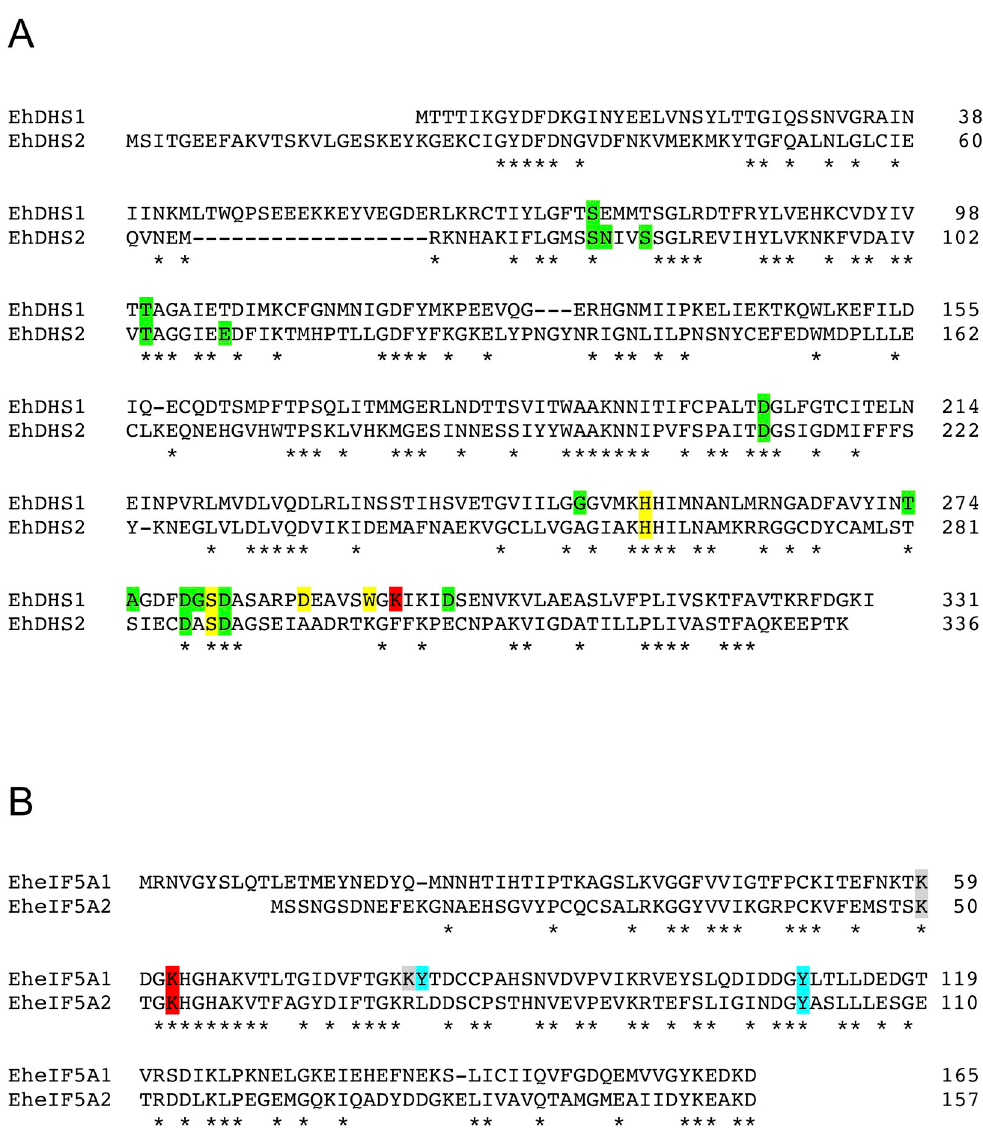
Fig 2. Multiple alignment of E . histolytica DHS and eIF5A protein sequences. Conserved residues are marked by asterisks ( � ). Sequence alignment was performed using ClustalW. (A) Amino acid sequence alignment of E . histolytica DHS isoforms. Accession numbers of these sequences are as follows: EhDHS1 (XP_653614), EhDHS2 (XP_653426). The catalytic lysine residue is shown in red background, whereas NAD + and spermidine binding sites are shown in green and yellow background, respectively. (B) Amino acid sequence alignment of E . histolytica eIF5A isoforms. Accession numbers of these sequences are as follows: EheIF5A1 (XP_657374); EheIF5A2 (XP_651531). The conserved lysine residues which are expected to be hypusinated are highlighted in red. Residues which are post-transnationally modified by acetylation and sulfation in human eIF5A, are shown in grey and cyan background, respectively.